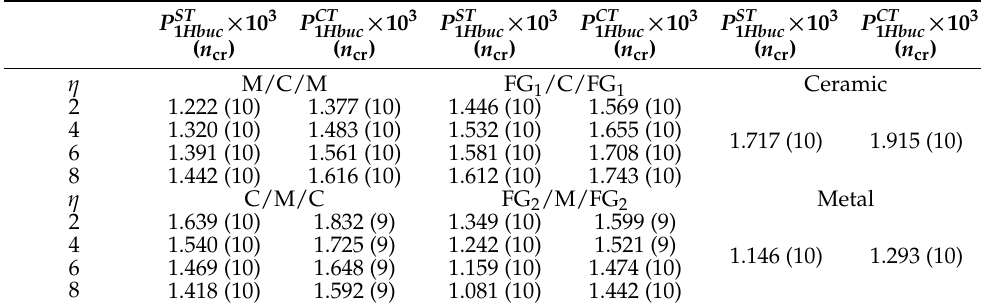
Table 4. Variations of P CT , P ST and ( n cr ) in various kinds of sandwich and monolayer cylindrical 1 Hbuc 1 Hbuc shells under clamped boundary conditions versus the η .